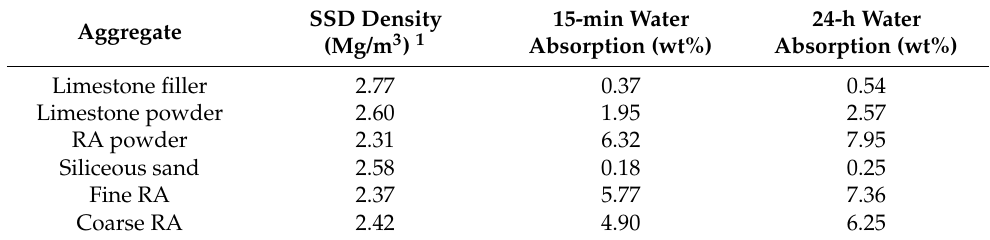
Table 1. Physical properties of